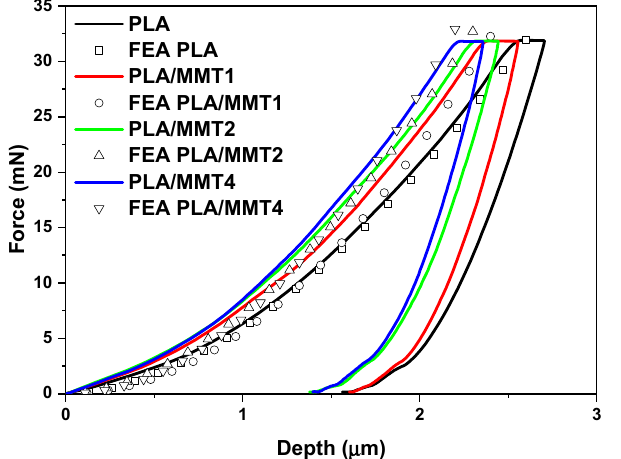
Figure 7. Comparison of load–depth nanoindentation curves of PLA and PLA/MMT nanocompo- sites.